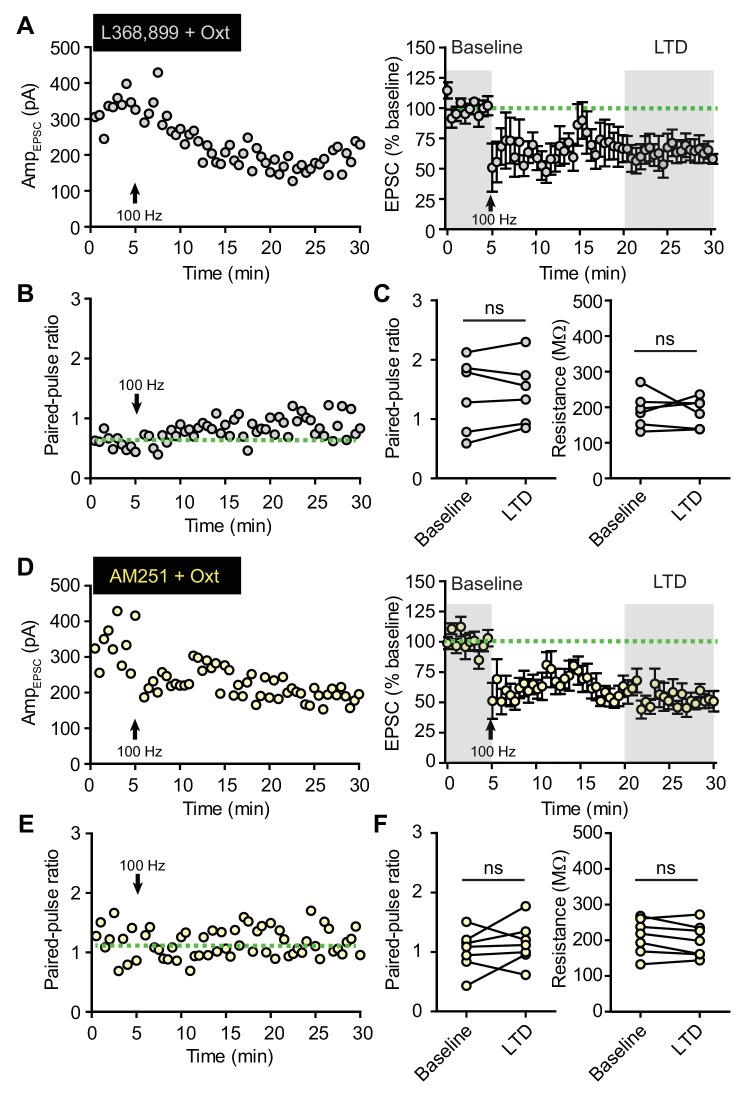
Oxytocin modulates EPSC amplitude during LTD through oxytocin and endocannabinoid receptors.(A) EPSC amplitudes recorded from one VTA DA neuron in the presence of oxytocin and OxtR antagonist (L368, 899), with LTD induction using 1 s long periods of 100 Hz stimulation, repeated 4 times with 10 second-long inter-train intervals (indicated by arrows). Right: summary results show normalized evoked EPSC amplitude across time in the presence of oxytocin and OxtR antagonist. EPSC amplitudes were normalized based on a 5 min baseline recording (first shaded interval). n = 6 neurons from four mice. (B) PPR (50 ms ISI) measurements from one VTA DA neuron in the presence of oxytocin and OxtR antagonist during LTD induction. (C) Summary data for PPR and input resistance in the presence of oxytocin and OxtR antagonist during LTD induction. Wilcoxon matched-pairs signed rank test, n = 6 neurons from four mice. (D–F) Same as (A–C), but with oxytocin and CB1 receptor inverse agonist (AM251). n = 7 neurons from four mice.